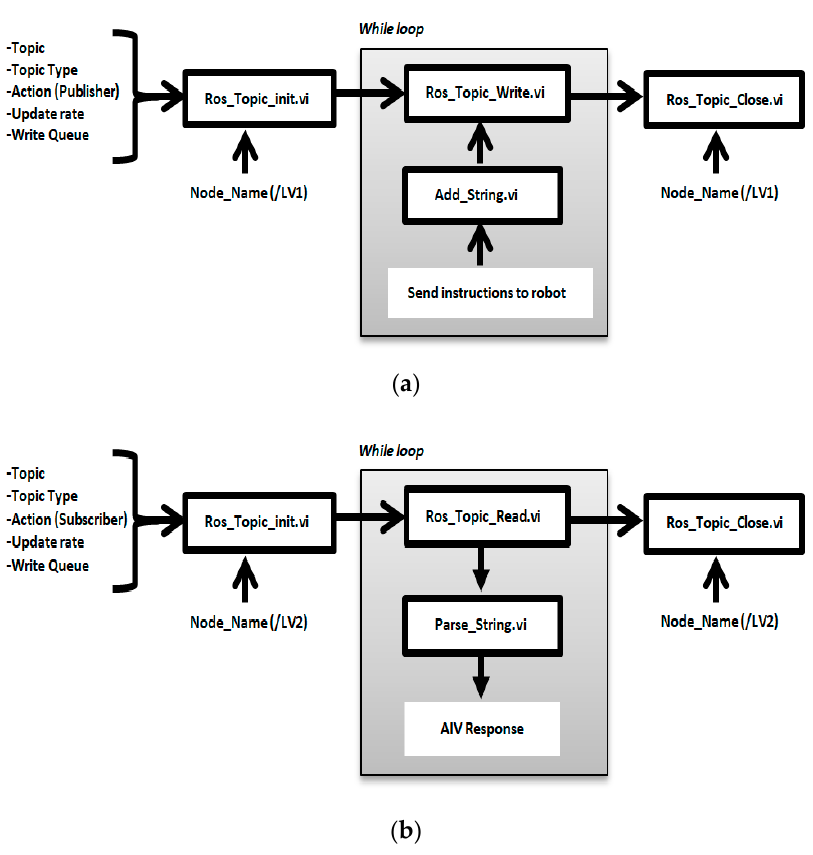
Figure 8. Block diagram of LabVIEW Publisher/Subscriber node. ( a ) Publisher; ( b ) Subscriber.